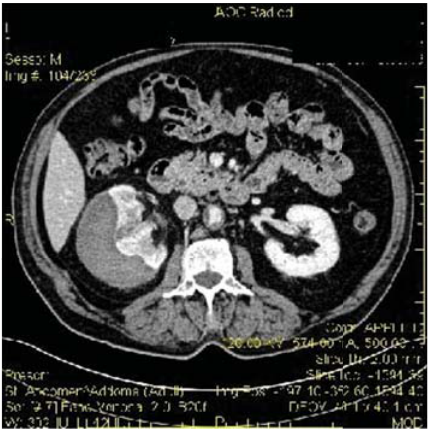
Figure 3: CT aspect of the hematoma.